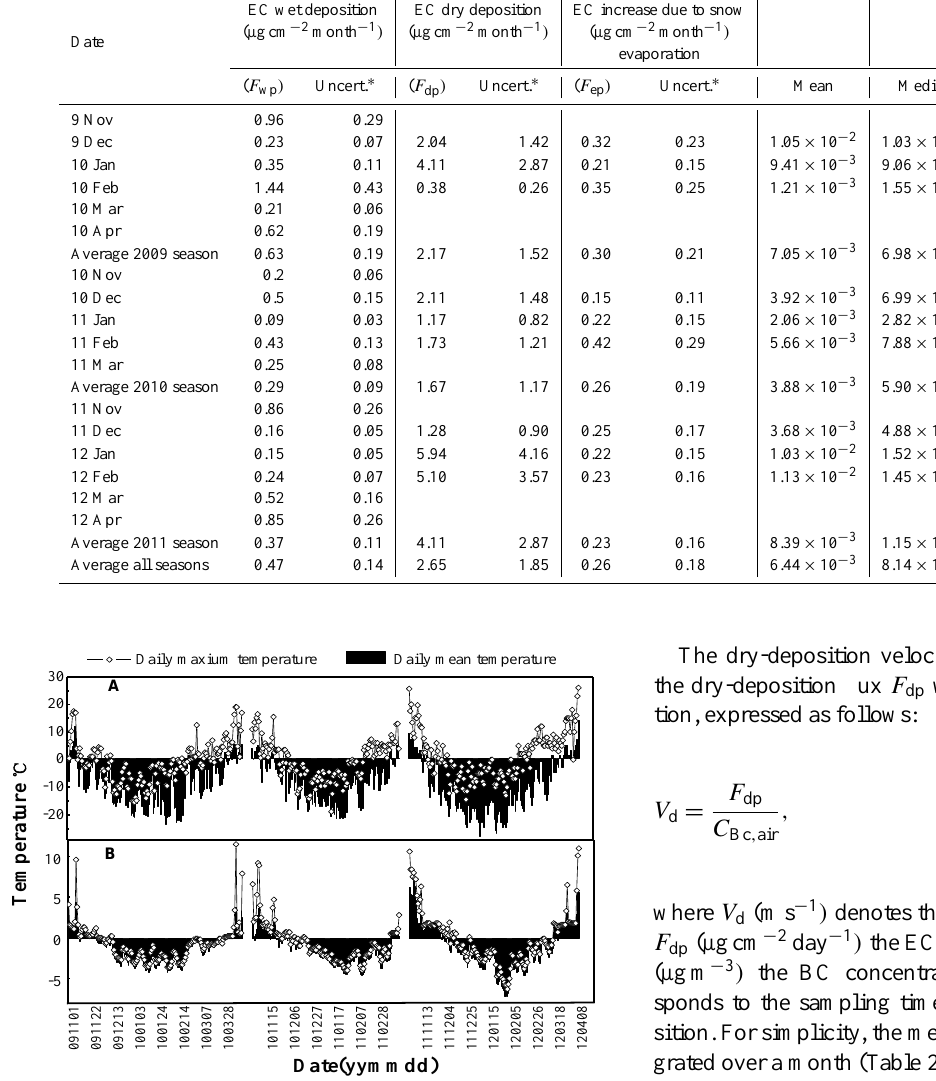
Fig. 8. Daily mean and maximum temperatures of air near snow surface (2 cm above the surface) (A) and snow–soil interface (B) from 2009 to 2012.